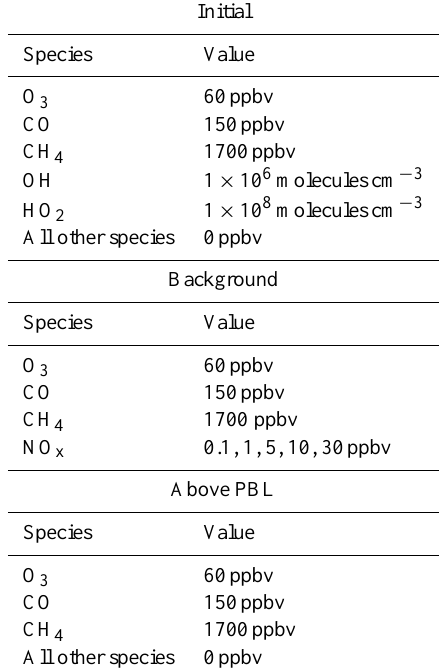
Table 1. Specified Initial, Background and Above PBL Mixing Ra- tios for Walker Branch Watershed